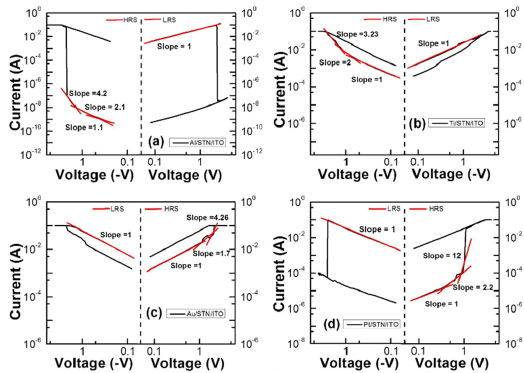
Figure 3. Fitting results of the top electrode/STN/ITO/glass structures in both high ‐ resistance state (HRS) and low ‐ resistance state (LRS) for ( a ) Al; ( b ) Ti; ( c ) Au; and ( d ) Pt.